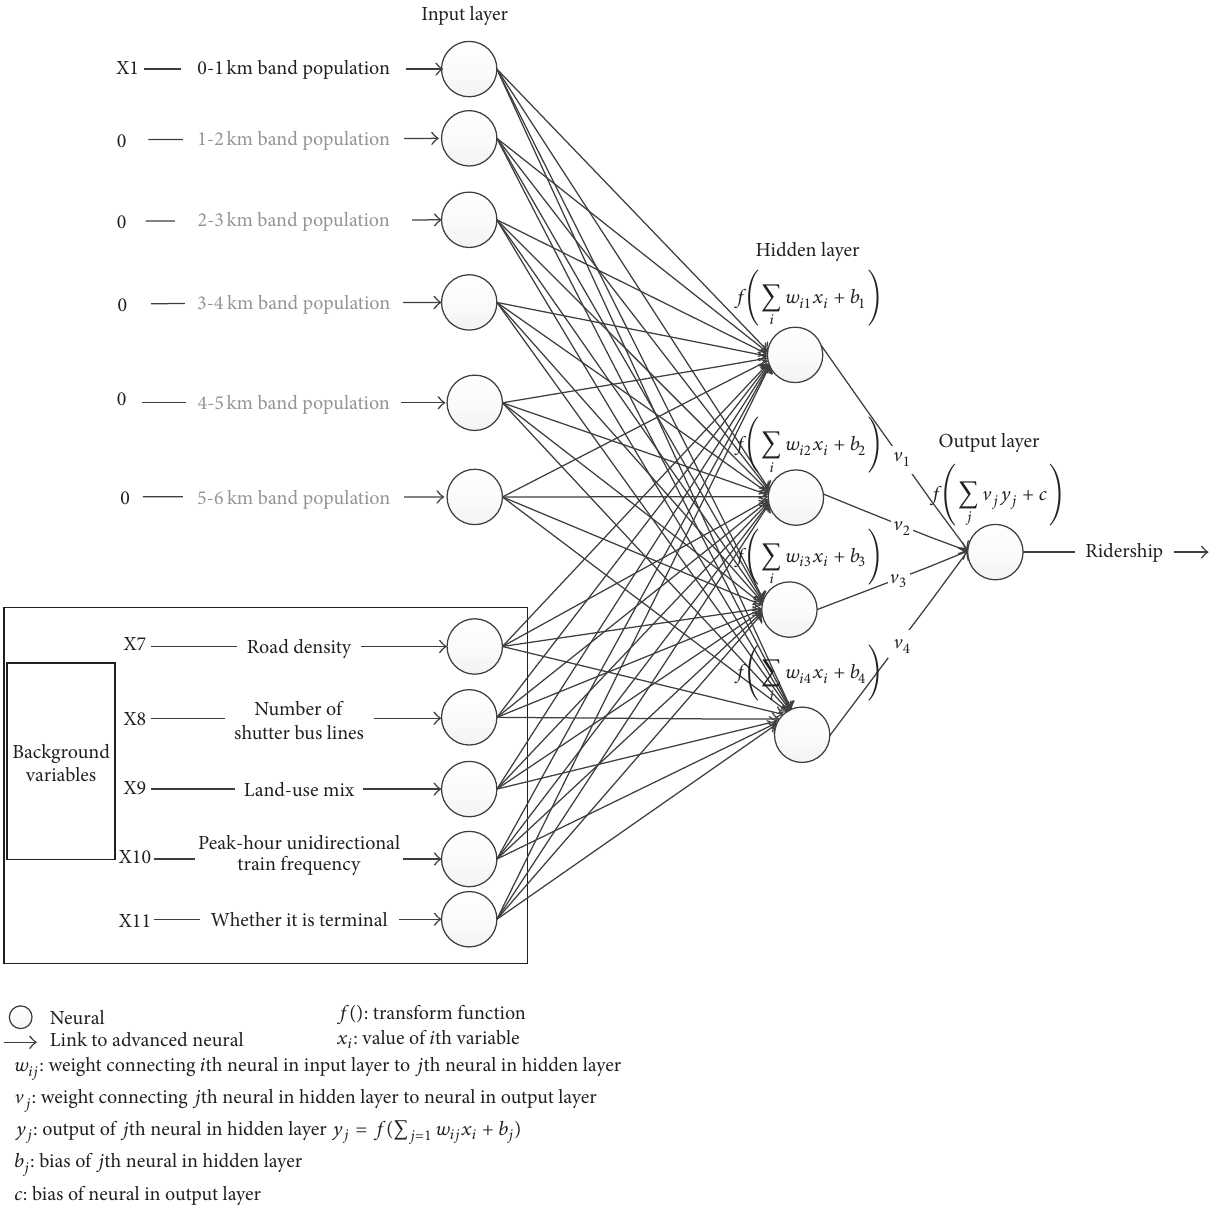
Figure 2: Contribution rate model for ridership of population within 0-1km